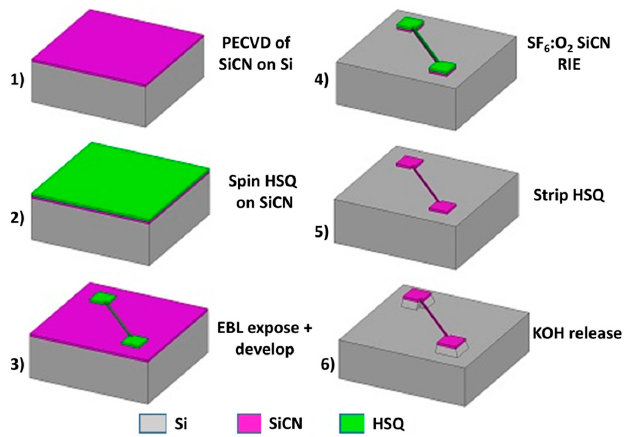
Figure 1. Process diagram for the fabrication of SiCN nanostrings. From [36].